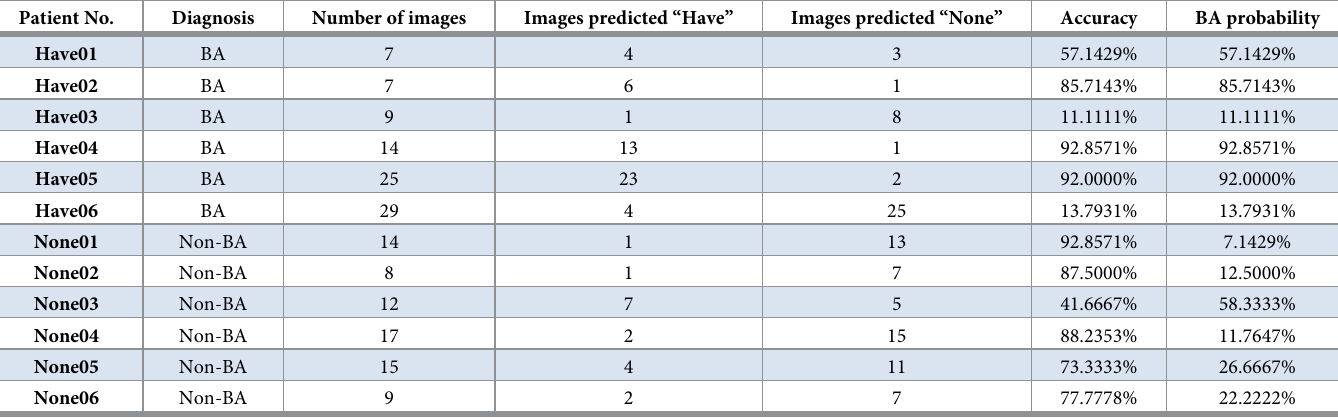
Images predicted “have” indicated AI diagnosis of BA, and images predicted “none” represented AI excluding